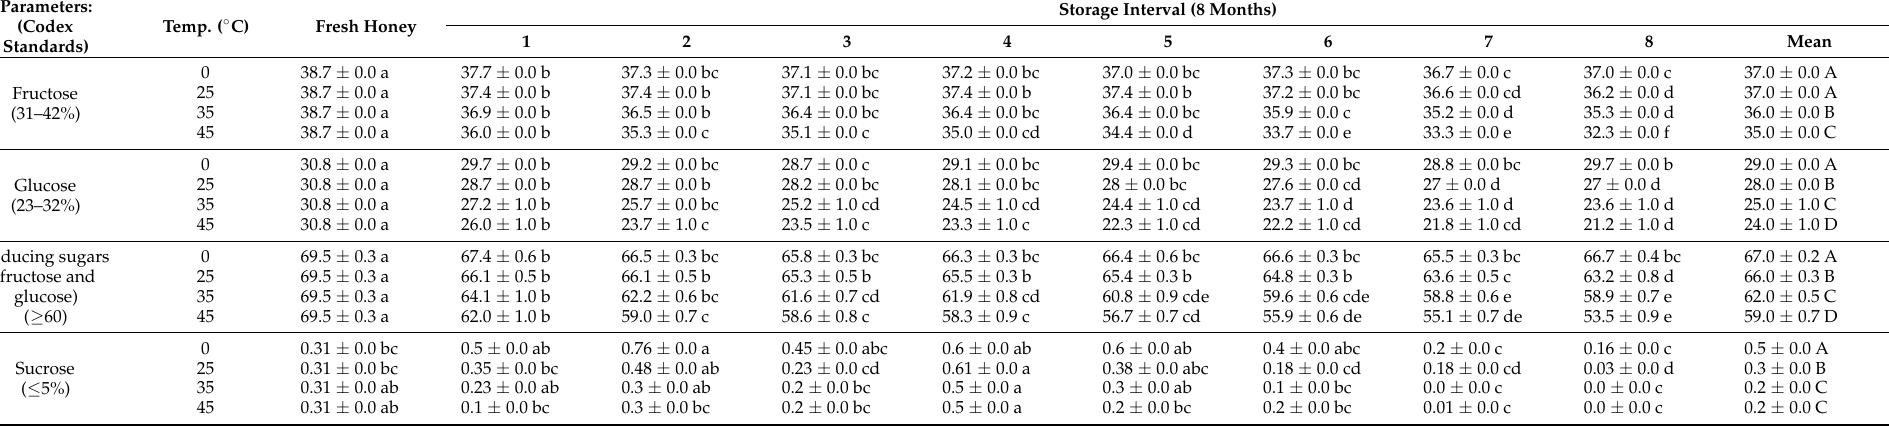
Table 3. Sugar analysis of Talh Acacia gerrardii honey according to different temperatures and storage intervals for eight months from